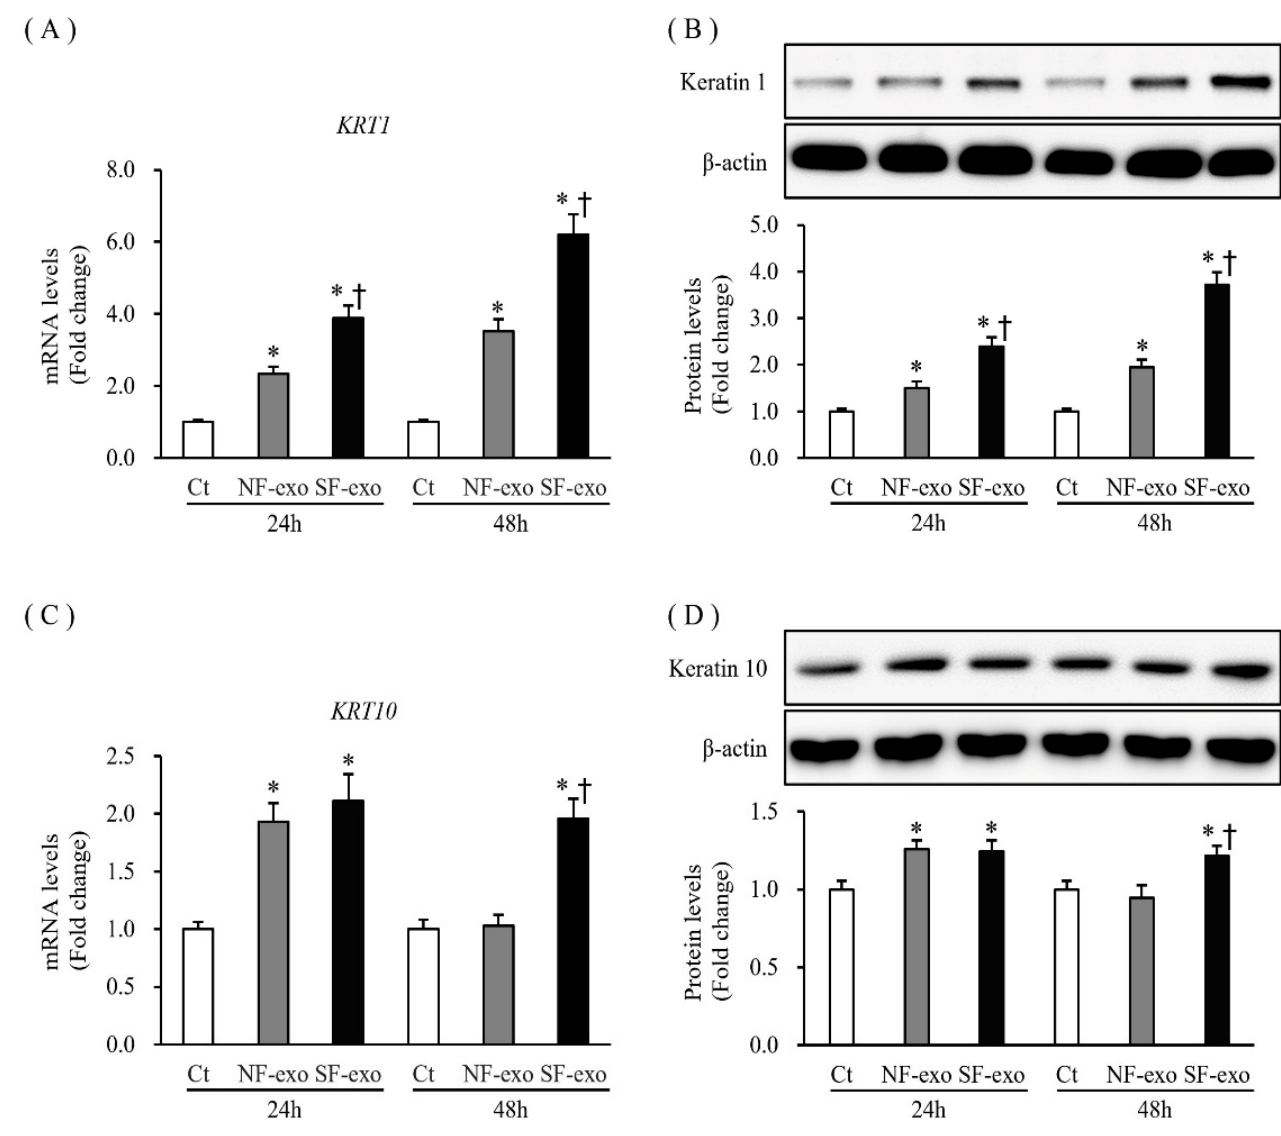
Figure 4. Expression of differentiation markers in NHKs after NF- and HTSF-exosome treatment. The mRNA and protein expression of KRT1 ( A , B ) in NHKs increased significantly at 24 and 48 h after treatment with 100 µ g/mL NF- or HTSF-exosomes, compared with that in the control cells; mRNA and protein expression of KRT1 significantly increased after treatment with HTSF-exosomes compared with NF-exosomes. The mRNA and protein expression of KRT10 ( C , D ) in NHKs increased and was unchanged at 24 h and 48 h after treatment with 100 µ g/mL NF-exosomes, respectively; however, mRNA and protein expression of KRT10 increased at 24 h and 48 h after treatment with 100 µ g/mL HTSF-exosomes, compared with that in control cells. * p < 0.05 for NF- or HTSF-exosome- treated cells versus the corresponding matched control cells. † p < 0.05 for HTSF-exosome-treated cells versus NF-exosome-treated cells. Data represent the mean ± SD; n = 4. Ct, DPBS-treated control cells; NHK, normal human keratinocytes; NF, normal tissue-derived fibroblasts; HTSF, hypertrophic scar tissue-derived